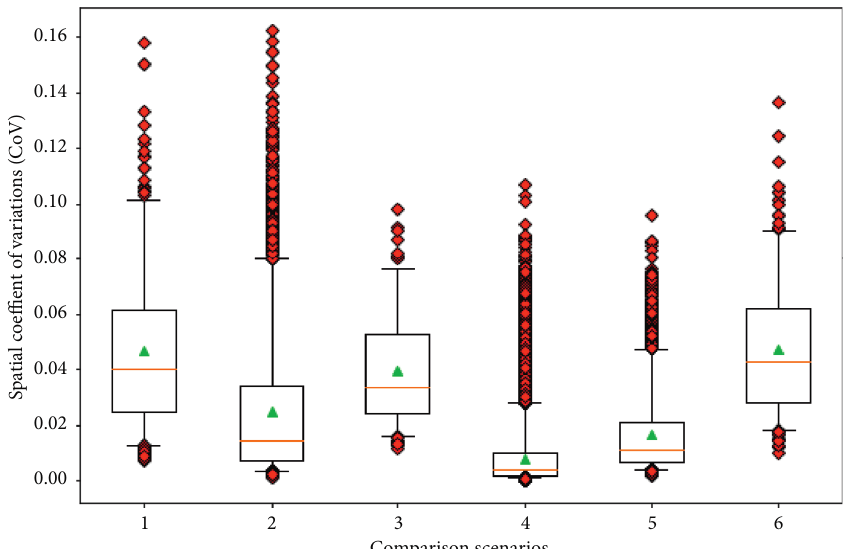
Figure 5: Spatial CoV lost due to downscaling. ( 1 ) SolarGIS in comparison with POWER. ( 2 ) SolarGIS in comparison with CLARA-A2. ( 3 ) SARAH-E in comparison with POWER. ( 4 ) SolarGIS in comparison with SARAH-E. ( 5 ) SARAH-E in comparison with CLARA-A2. ( 6 ) CLARA-A2 in comparison with POWER. Orange line, median and green triangle,